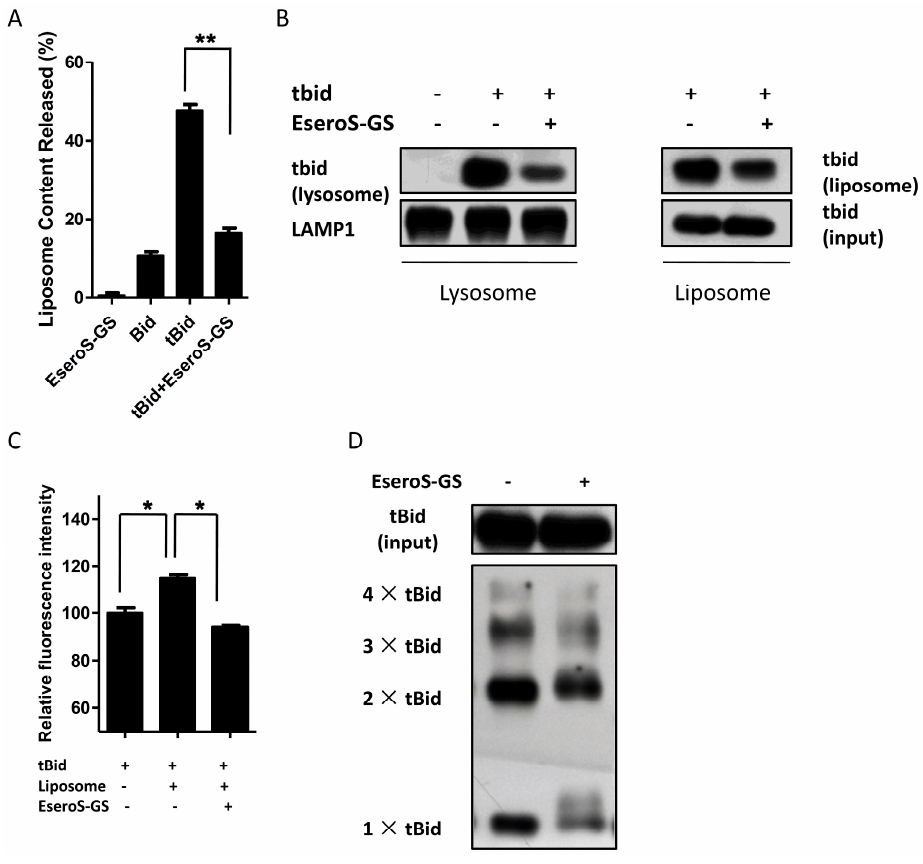
Figure 4. ESeroS-GS stabilizes lysosomal membranes by inhibiting the insertion and oligomerization of tBid to membranes. ( A ) ESeroS-GS inhibits tBid-induced permeabilization of model membranes; ( B ) ESeroS-GS attenuates the translocation of tBid to lysosomes and model membranes; ( C ) ESeroS-GS decreases the interaction between tBid and model membranes; ( D ) ESeroS-GS blocks the oligomerization of tBid within the membrane circumstances. *: p < 0.05; **: p < 0.01.